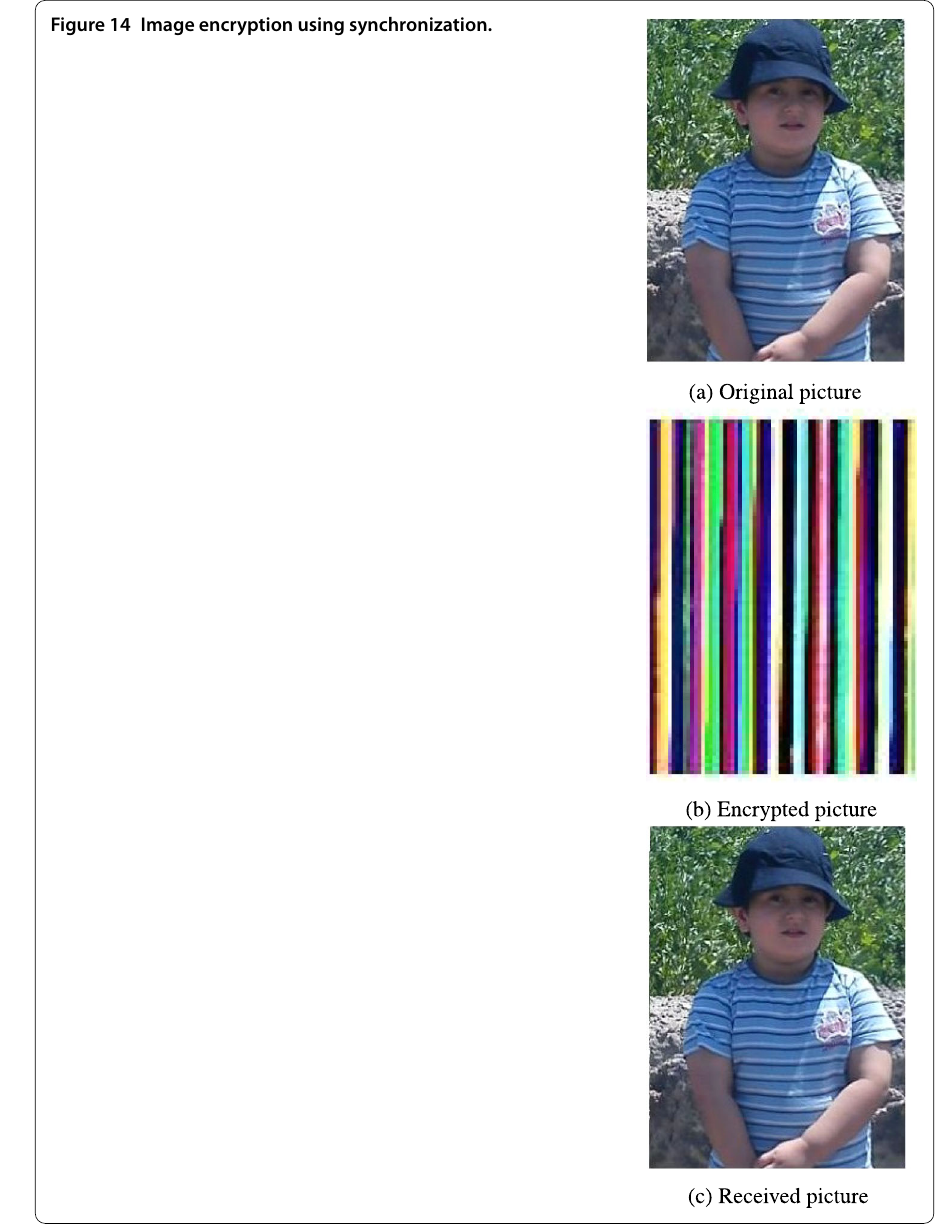
Figure 14 Image encryption using